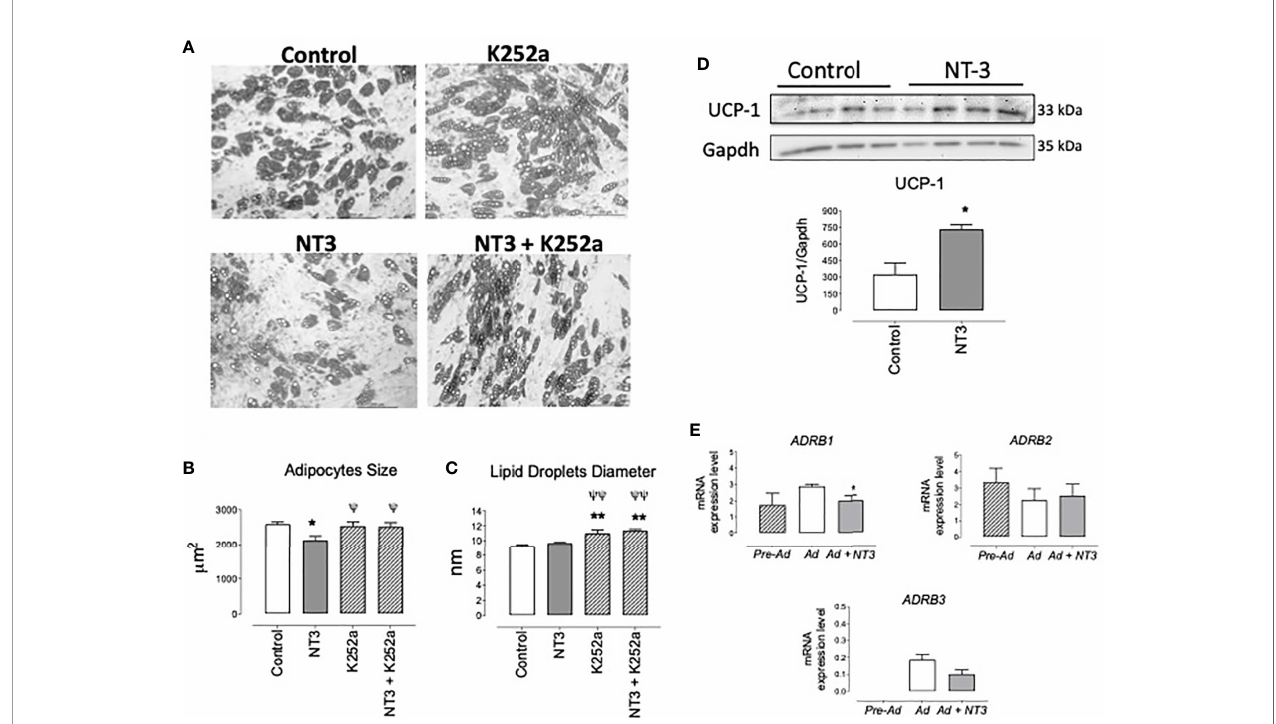
FIGURE 5 | The NT3/TrkC pathway modulates human adipocyte differentiation giving mature adipocytes with lower size and higher UCP-1 expression. (A) Representative images of adipocytes differentiated from human pre-adipocytes in absence (control) or in presence of NT3 (32 ng ml − 1 ), K252a (0.2 µM), and NT3 + K252a. Quanti fi cation of adipocytes size (B) and lipid droplets diameter (C), calculated from fi ve different experiments performed in duplicate, six fi elds by plate, 10 cells, and 25 lipid droplets by fi eld, * P < 0.05, ** P < 0.01 vs control, y P < 0.05, yy P < 0.01 vs NT3, one-way ANOVA followed by Newman-Keuls test (D) Representative immunoblot and quanti fi cation (bar diagram) of the expression of UCP-1 in human adipocytes differentiated in presence or not of NT3 (32 ng ml − 1 ), * P < 0.05, Student ’ s t test. (E) Expression of ADRB1, ADRB2, and ADRB3 in human preadipocytes (Pre-Ad) and adipocytes differentiated in absence (Ad) or presence (Ad + NT3) of NT3 (32 ng ml − 1 ) * P < 0.05 vs Ad, Student ’ s t test. Values of mRNA in bar diagrams are expressed as 2 - D Ct × 10 4 using Gapdh as a housekeeping gene. Data are mean± SEM of fi ve different